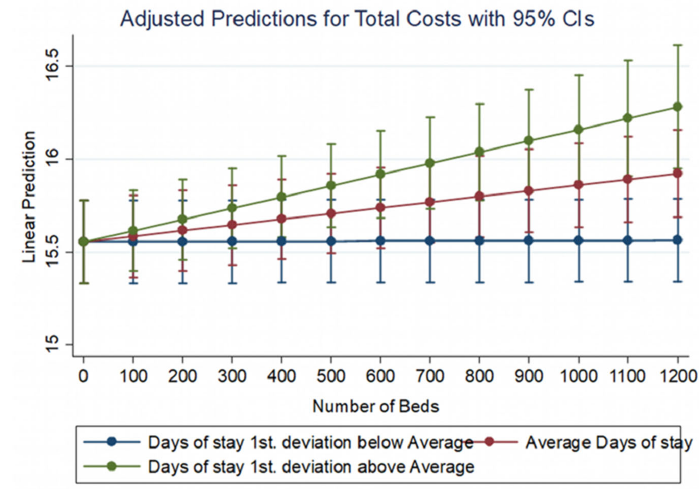
Figure 3. The impact of hospitalization days on total costs for different numbers of beds.